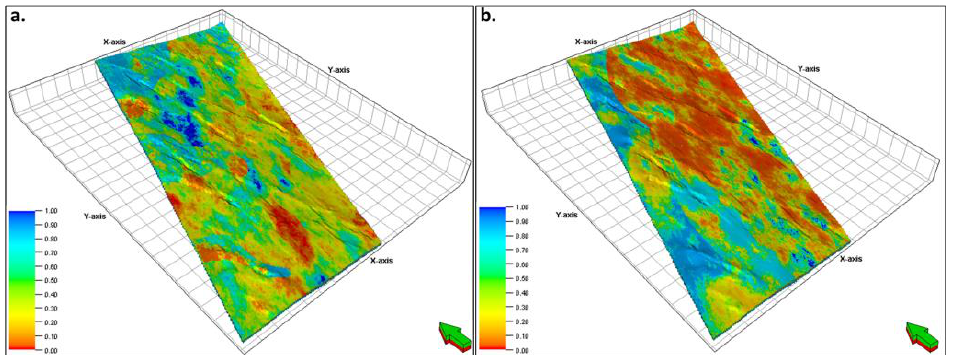
Figure 13. The shale volume model of Unit 4 ( a ) and Unit 5 ( b ). The model presents a scattered morphology, which indicates tidal channels in the south of the field. In Unit 5, the model presents a more continuous morphology, which indicates sheet-like deposition in a higher accommodation space after the middle-scale, descending half cycle. The model also shows inverse variation trends in Unit 4 and Unit 5.